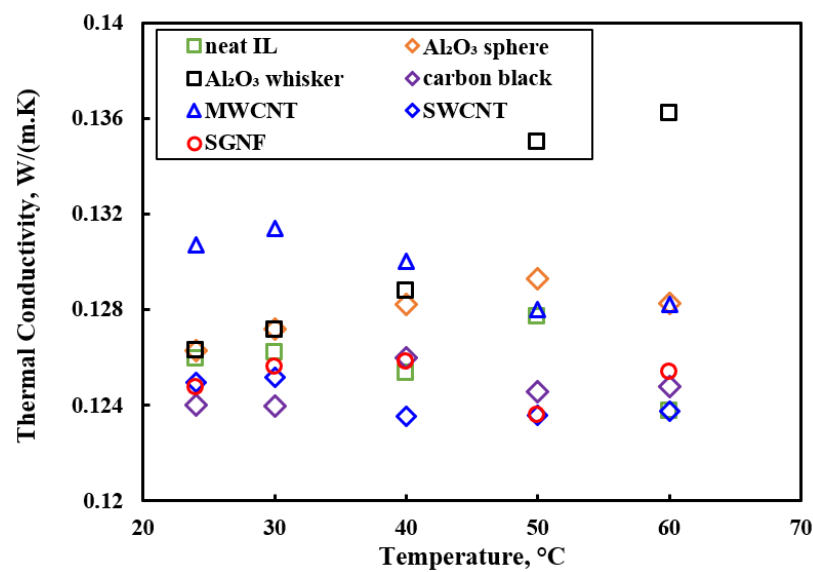
Figure 9. Effect of temperature on the thermal conductivity of different ILs-based nanofluids [60]. Reproduced with permission from [Foxr], [Energy Fuels ]; published by [ACS], 2013.